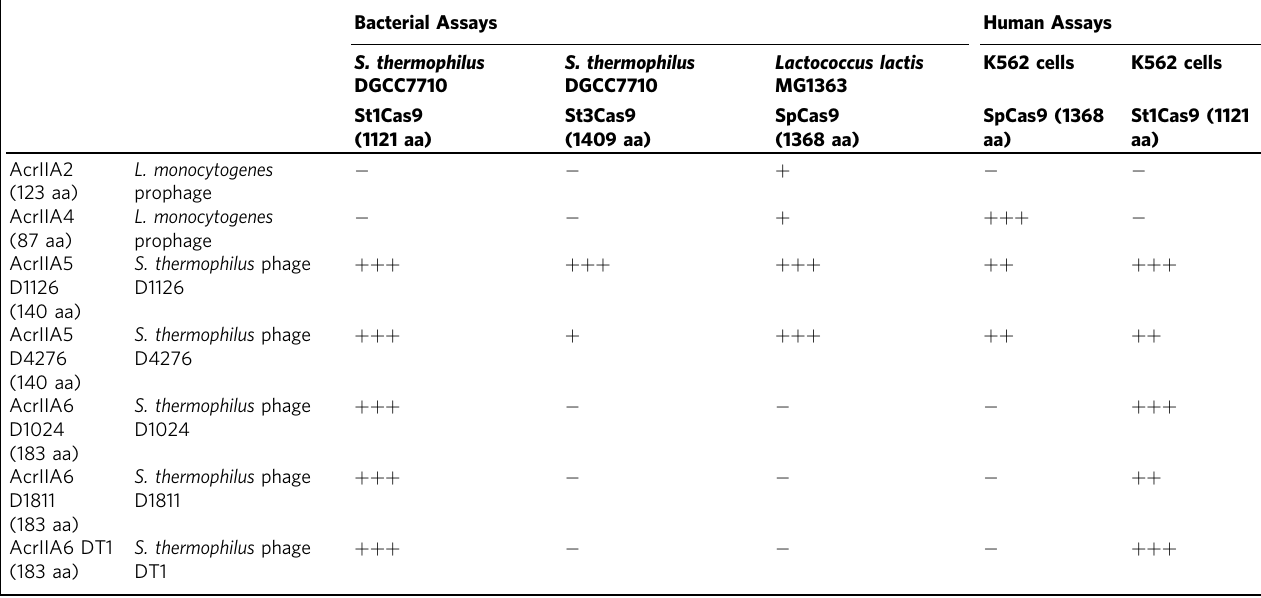
Table 1 Summary of AcrIIA